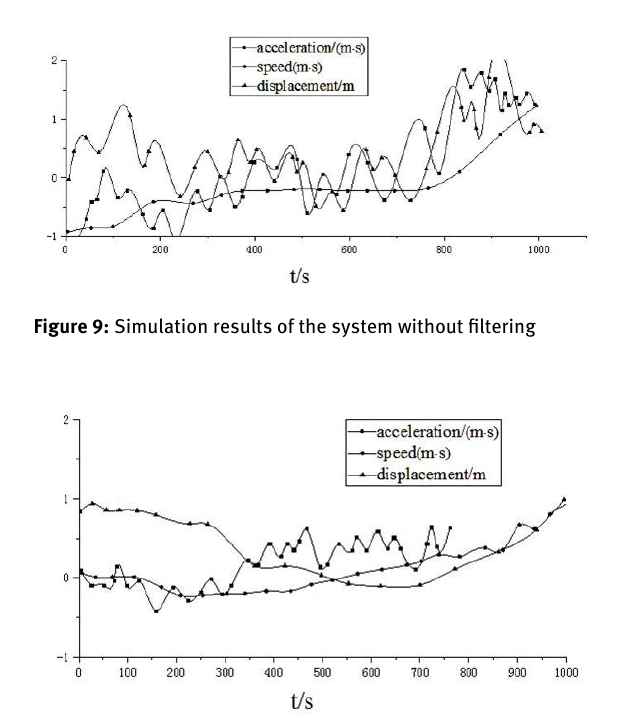
Figure 8: Simulation model